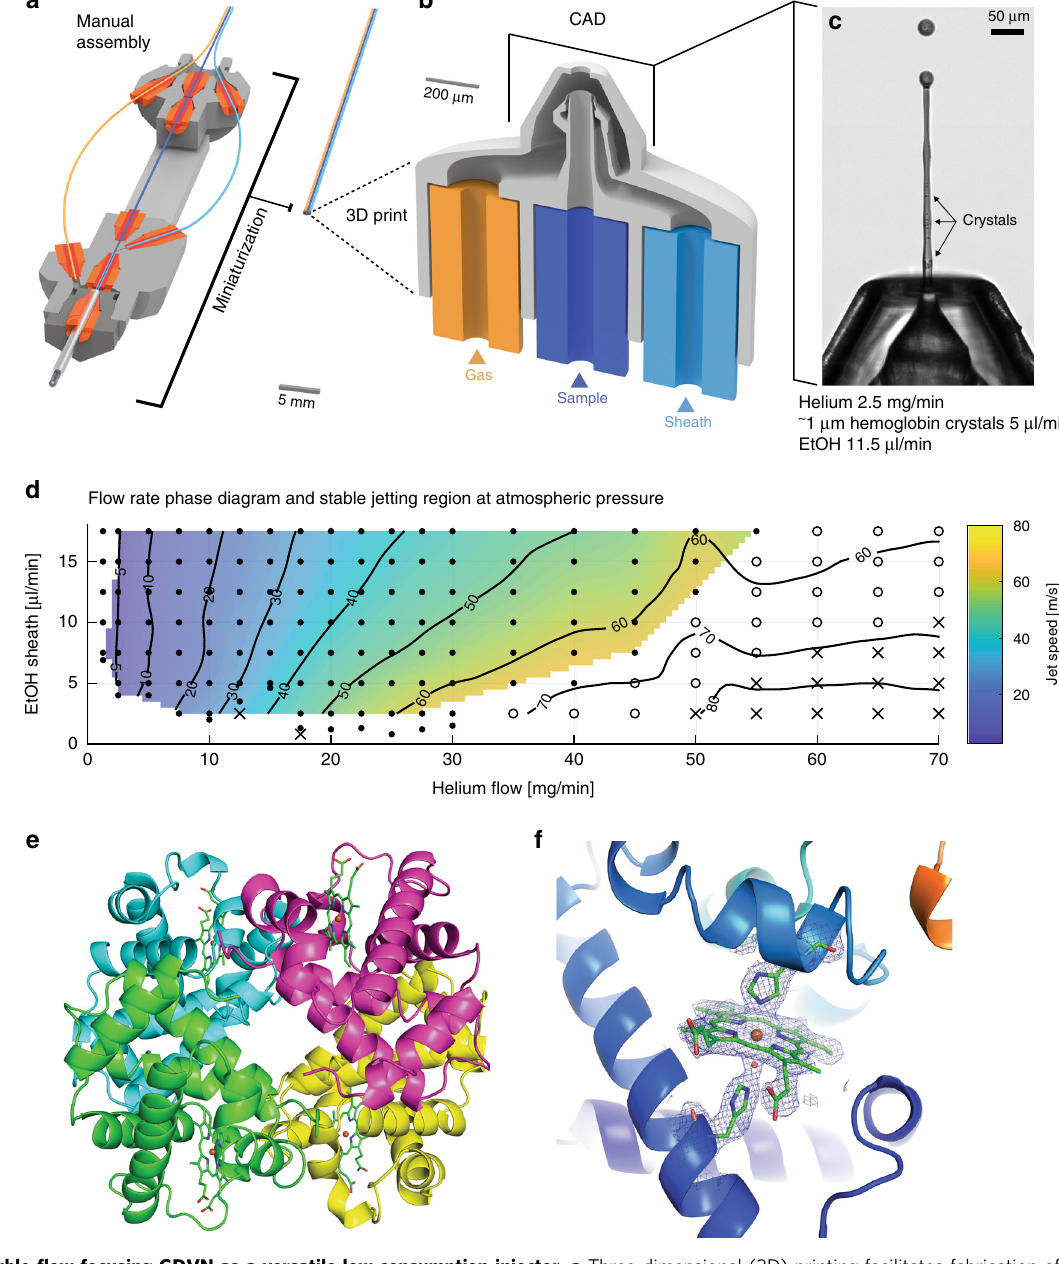
Fig. 4 Double- fl ow-focusing GDVN as a versatile low consumption injector. a Three-dimensional (3D) printing facilitates fabrication of intricate structures that are dif fi cult or impossible to manufacture otherwise. The manual DFFN design assembles three polished glass capillary ori fi ces into a machined 10 cm long aluminum body, which we compress into a single integrated piece of <1 mm in size. b Three-dimensional (3D) DFFN CAD design with three capillary inlets featuring a 75 µ m inner diameter liquid and a 70 µ m diameter gas ori fi ce. The sheath liquid channel circumvents the sample line close to the nozzle tip to prevent interferences from stagnating gas bubbles. c Approximately 3 μ m sized Hemoglobin crystals are visible in the liquid jet